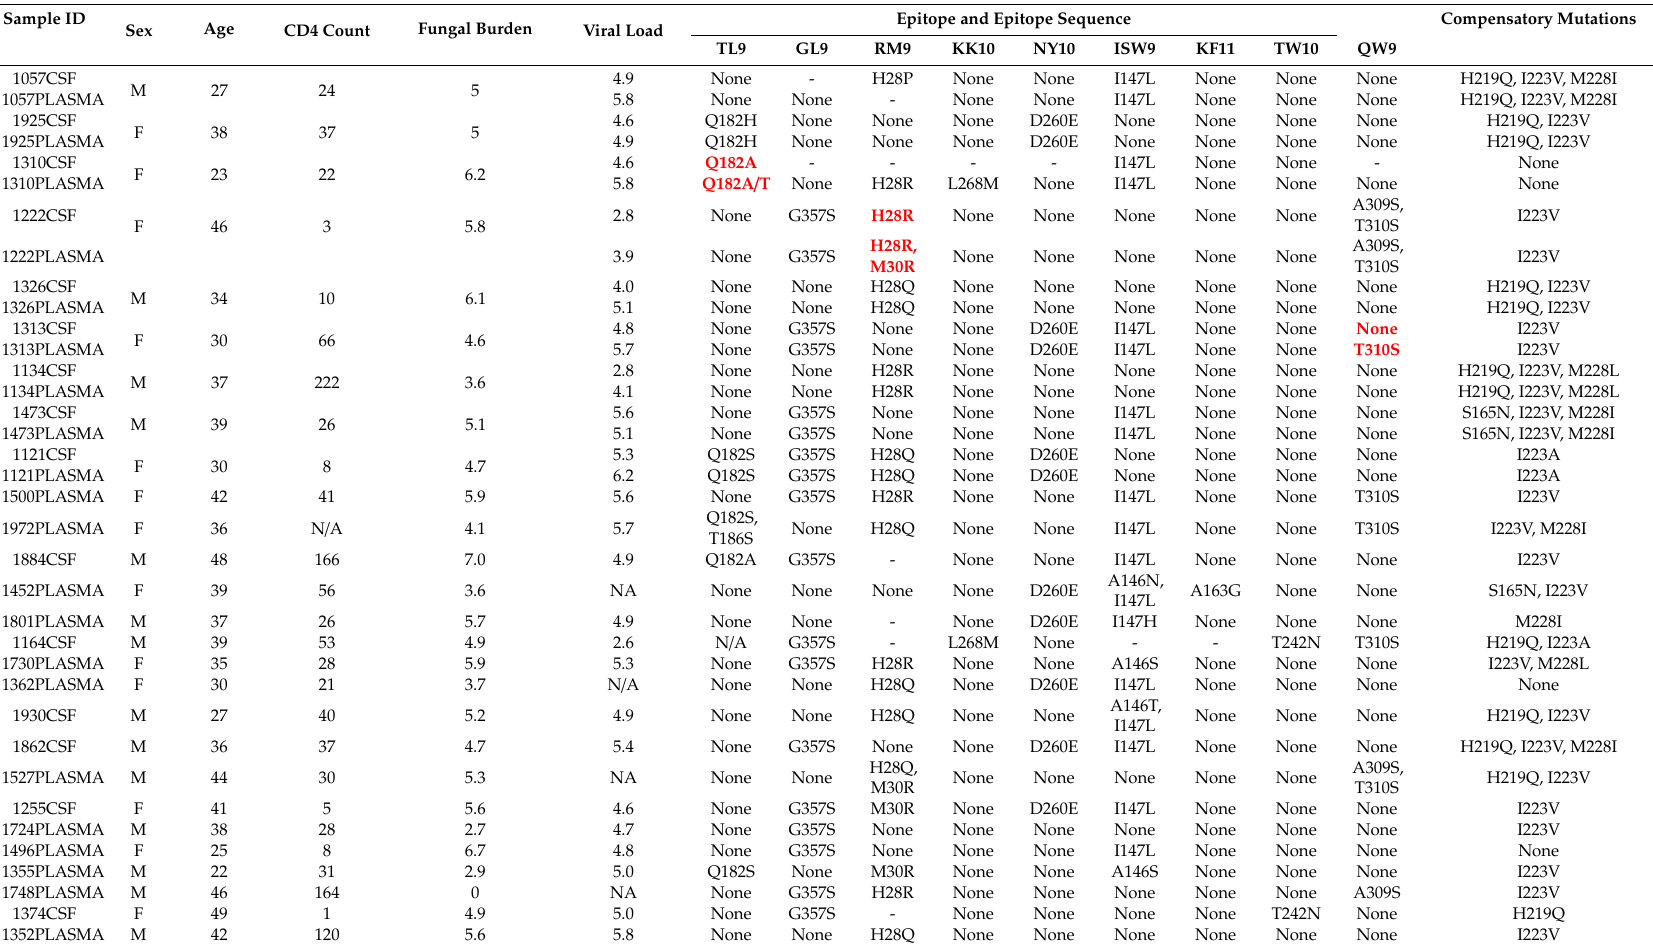
Table 2. HIV-1 gag cytotoxic T-lymphocyte (CTL) escape mutations in the CSF and plasma of individuals with HIV-associated